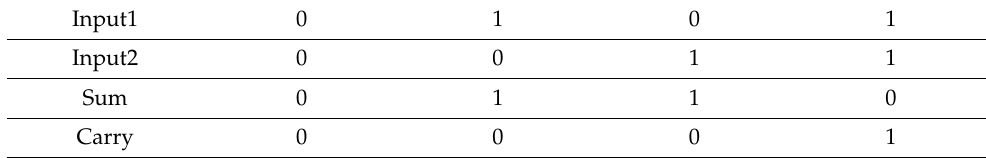
Table 3. Logic truth table of the half adder.